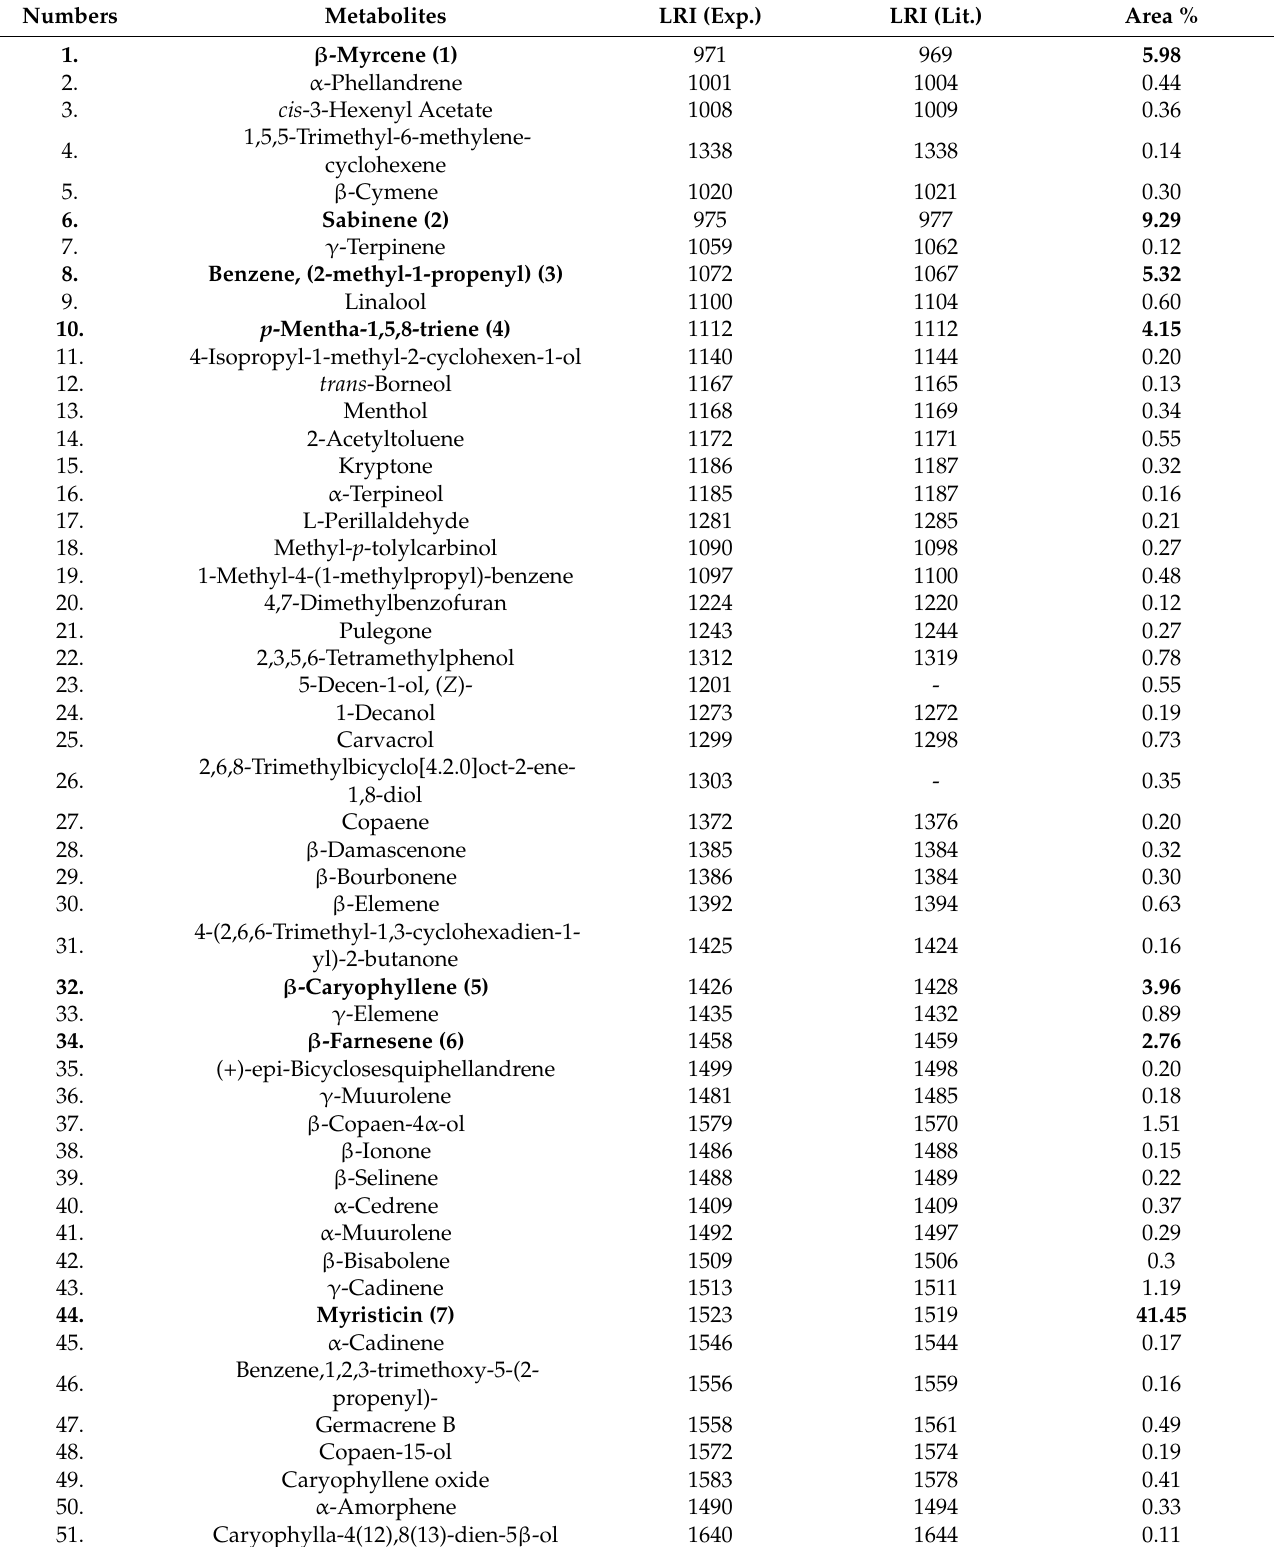
Table 1. Chemical composition of PCEO analysed using